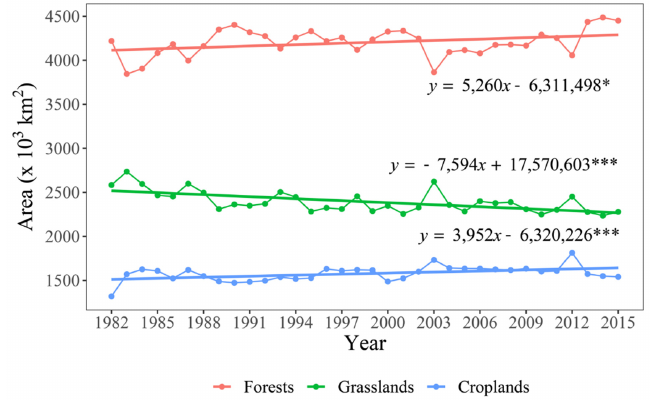
Figure 6. Temporal changes for the total areas of forests, croplands, and grasslands in the EASM region from 1982 to 2015 (The forests class includes the evergreen broadleaf, deciduous needleleaf, deciduous broadleaf, and mixed forests as well as woody savannas and savannas, as presented in Table 6. The unit of the change is km 2 /year; while *, **, and *** represent the 10%, 5%, and 1% significance levels, respectively).